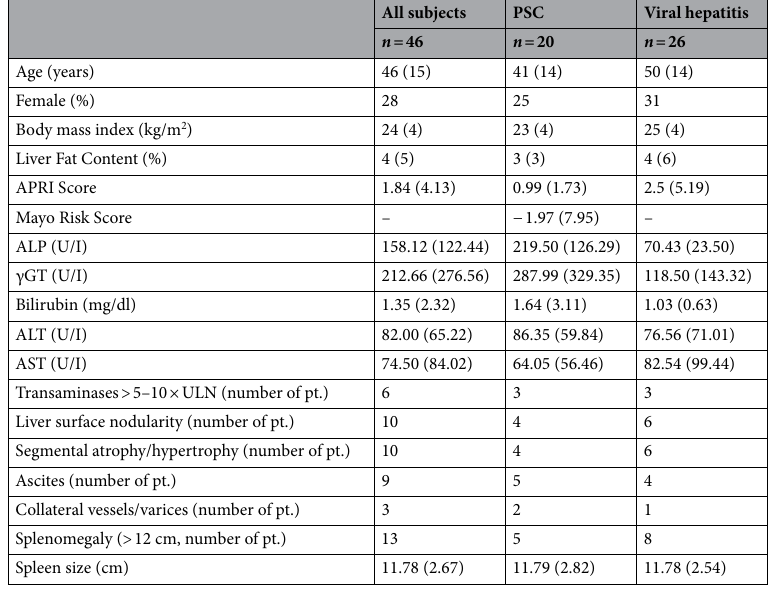
Table 1. Baseline characteristics of subjects. If not otherwise specified, data are means and numbers in parentheses are standard deviations. APRI aspartate aminotransferase-to-platelet ratio index, ALP alkaline